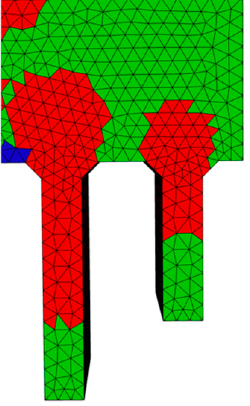
Figure 9. Detail view of staircase orientation ( 6 ) from Figure 6.